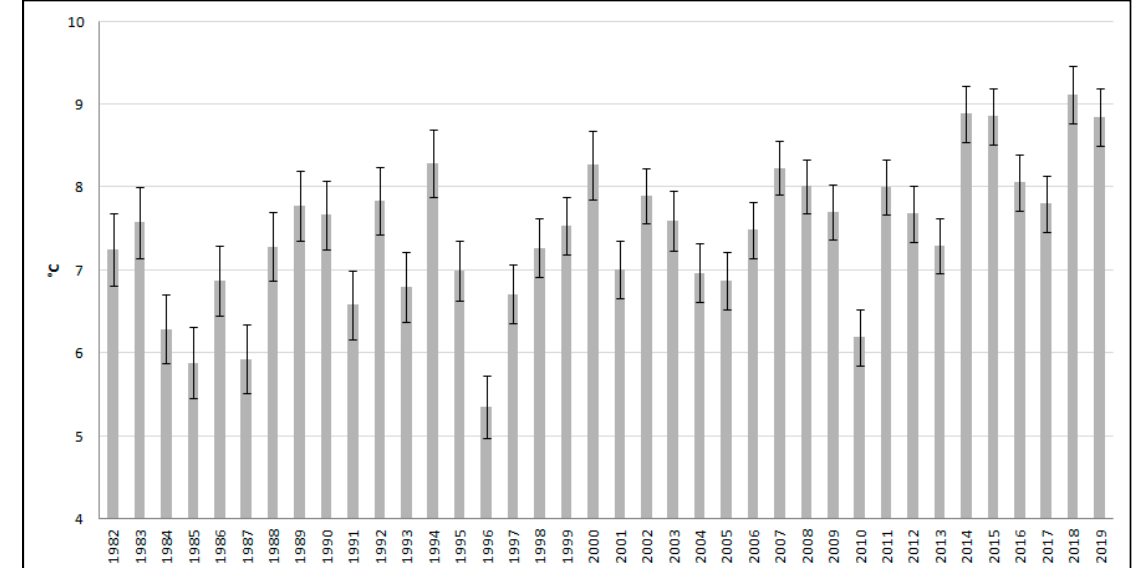
Figure 5. Graph of average annual temperature with Ensemble Data Assimilations (EDA) uncertainties during the years 1982–2019 in the Koj č ice area.